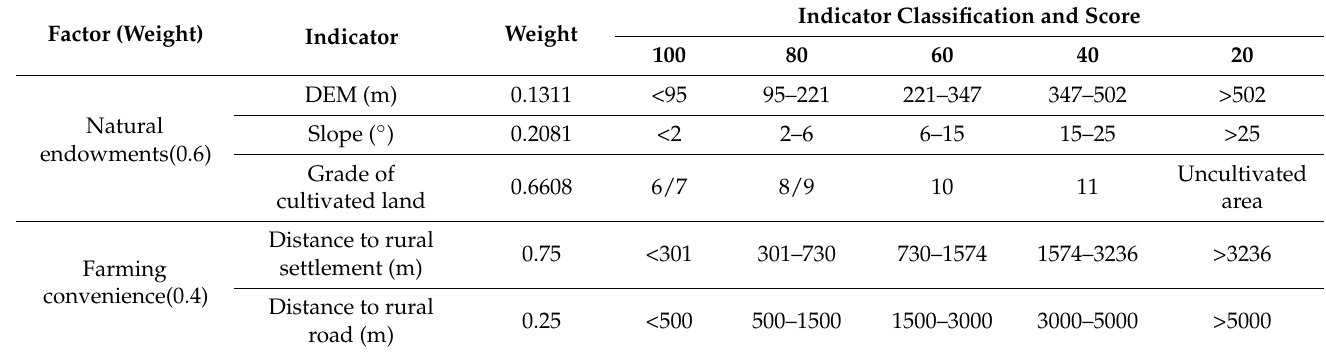
Table 2. Evaluation index system for cultivated land